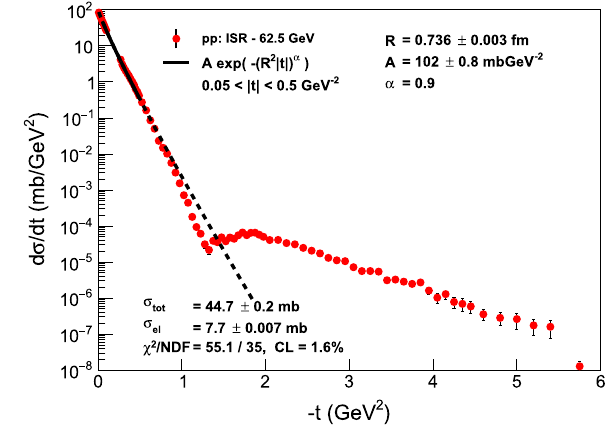
Fig. 37 Zeroth-order Lévy fits to the cone region of the differential cross-section data on pp elastic scattering at with fixed α = 0 . 9, A and R being free fit parameters